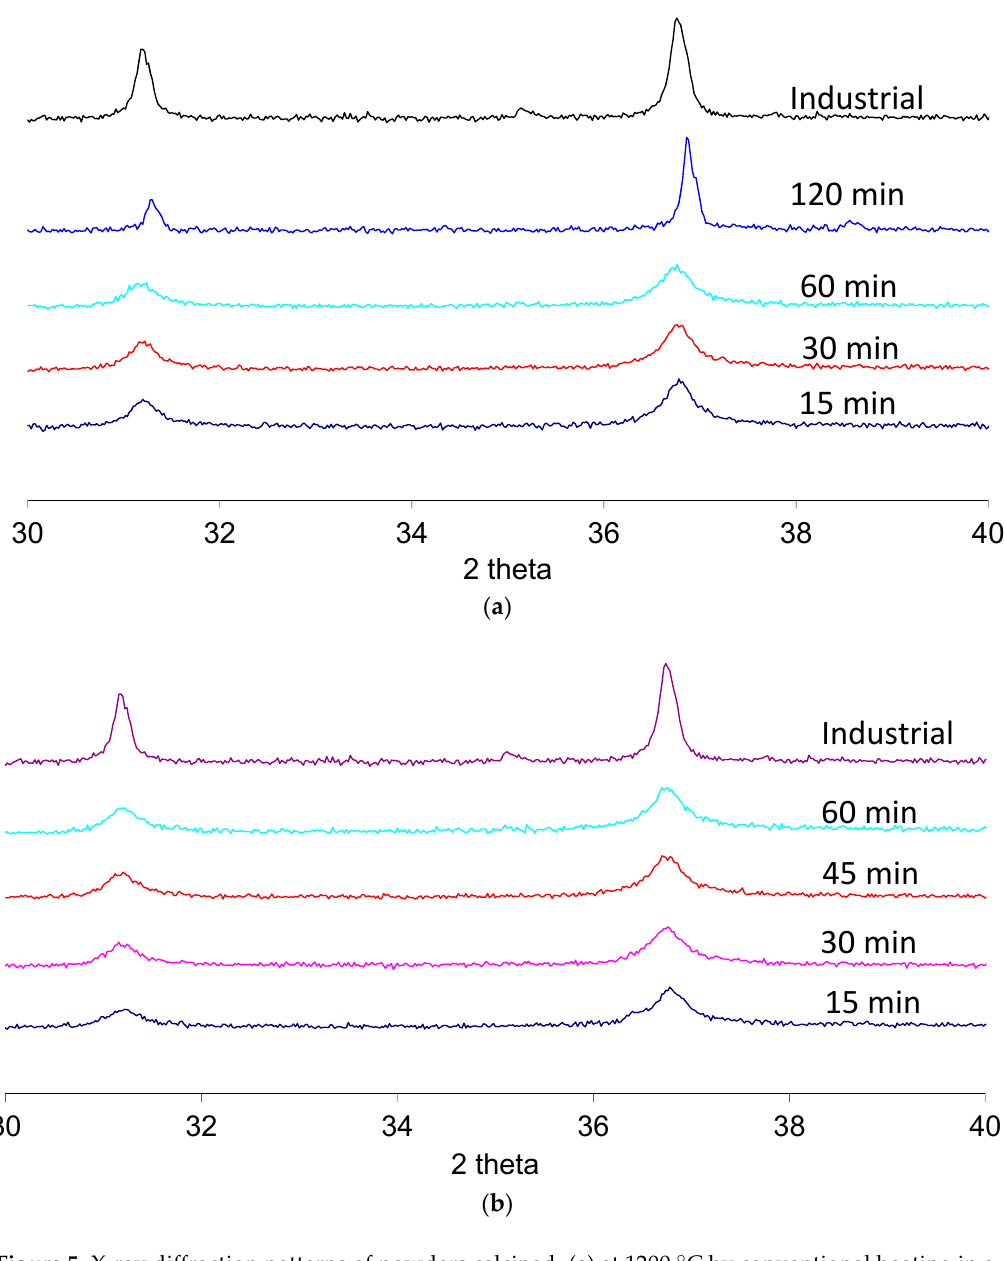
Figure 5. X-ray diffraction patterns of powders calcined: ( a ) at 1200 °C by conventional heating in a muffle furnace; ( b ) at 1100 °C by microwave heating, for different times, compared to the industrial standard pigment (240 min industrial cycle).